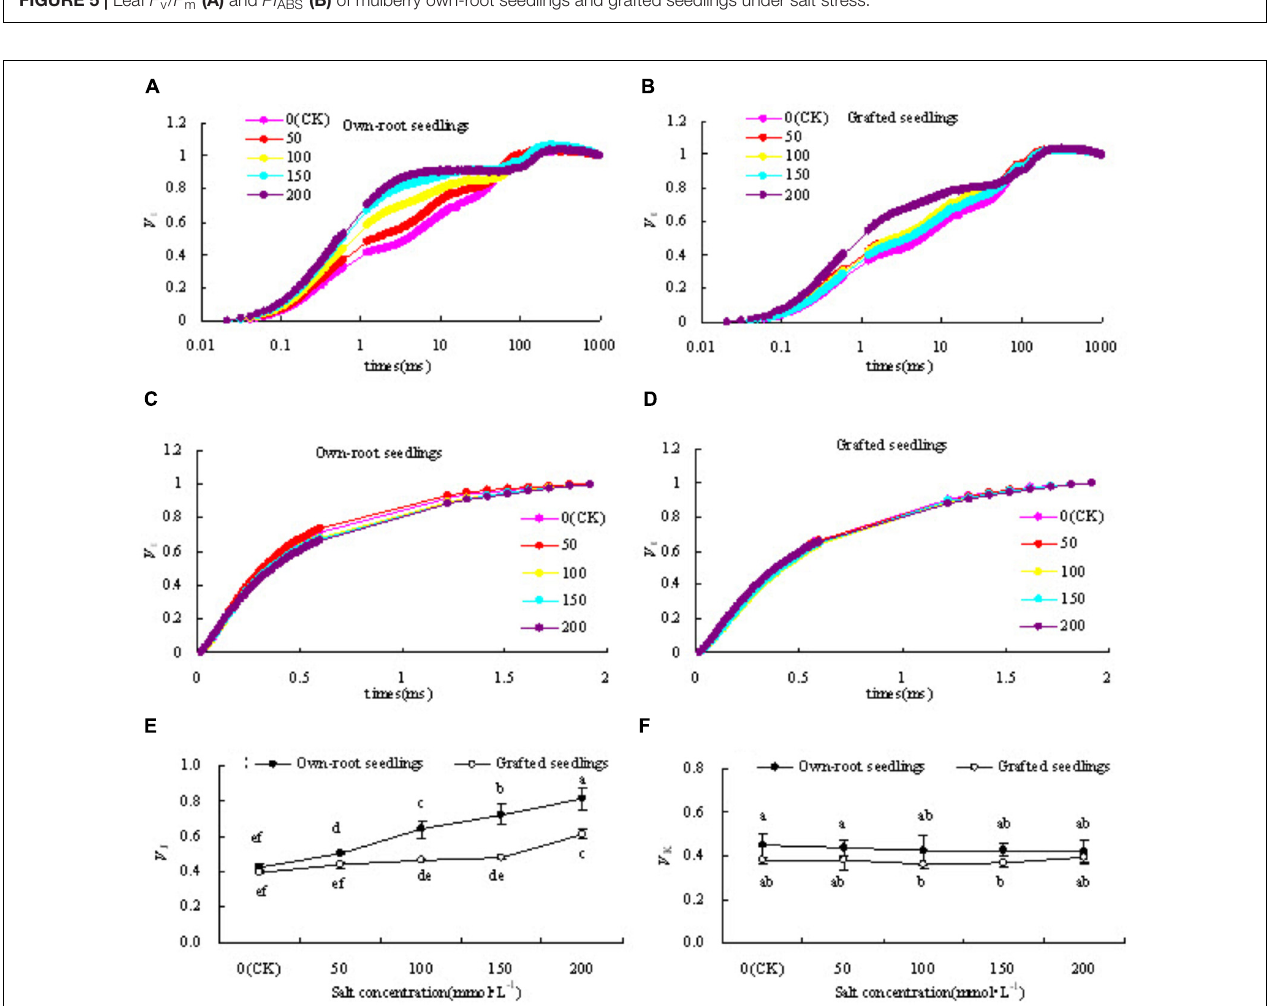
FIGURE 6 | V O − P (A,B) , V O − J (C,D) , V J (E) and V K (F) of mulberry own-root seedlings and grafted seedlings leaf under salt stress.